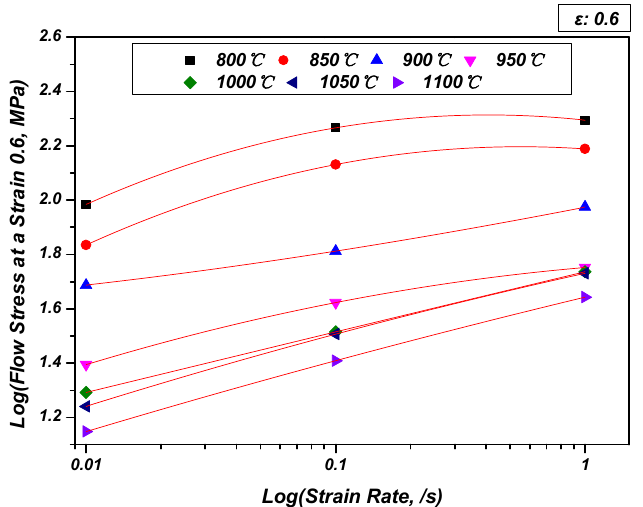
Figure 6. Flow stress curves at different temperatures as a function of strain rate ( ε = 0.6).